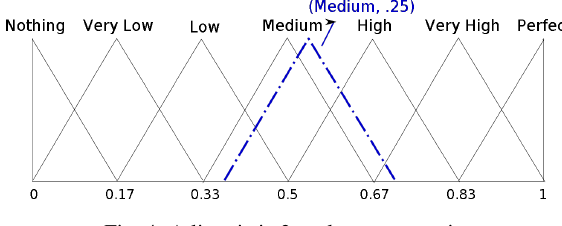
Fig. 4. A linguistic 2-tuple